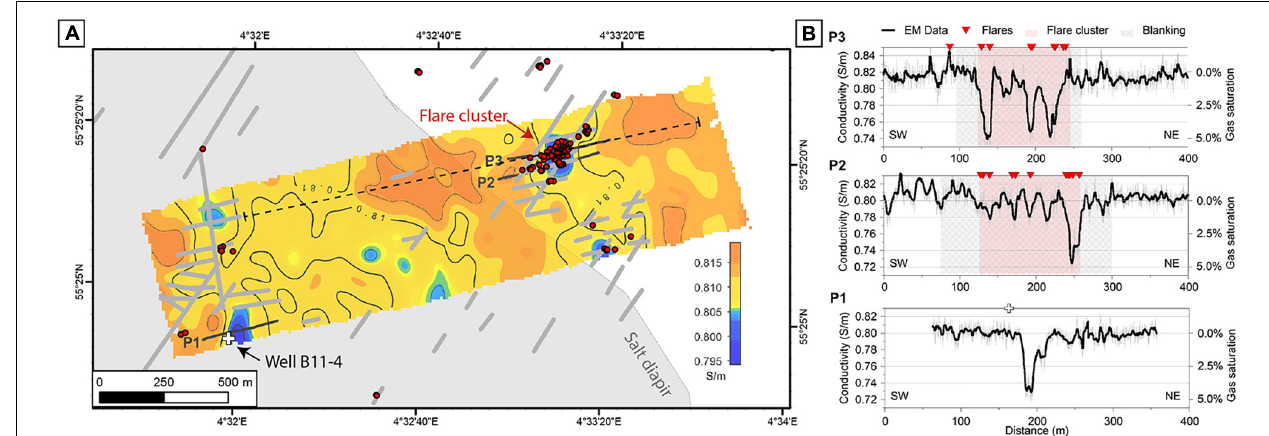
FIGURE 7 | Sediment electric conductivity data of the benthic EM Profiler. (A) Gridded 10 kHz EM conductivity data with flare locations (red dots), acoustic blanking from subbottom data (gray lines), and transect of subbottom profile B ( Figure 5B ; dashed line). (B) Selected profiles crossing conductivity minima (indicated by black lines in a; gray: raw data, black: median filtered) with projected flare locations. Background colors indicate areas of high flare density and acoustic blanking. Gas saturation estimates are based on the conductivity contrast (Eq. 1). A white cross marks the location of borehole B11–4 in both figures.